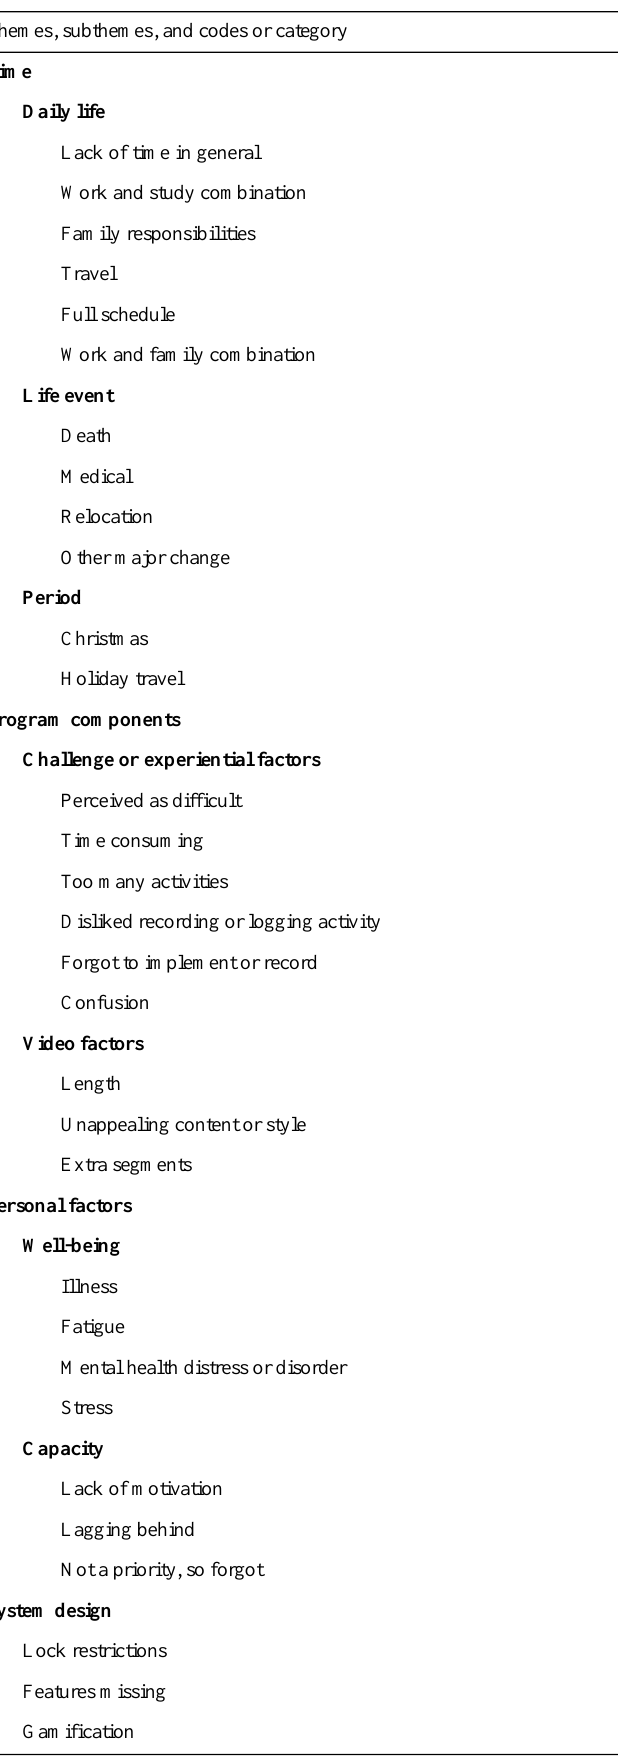
Table 2. Perceived barriers to adherence—themes, subthemes, and codes.